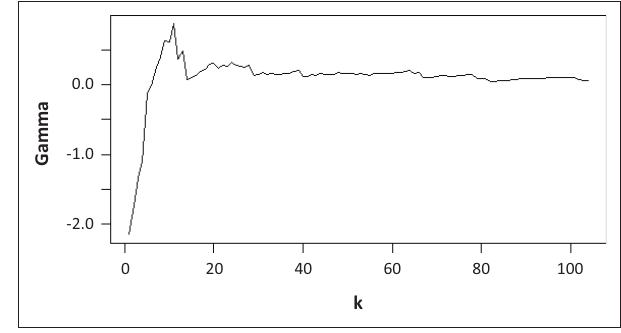
FIGURE 16: Kenya – Peak over threshold estimates to determine the threshold value.